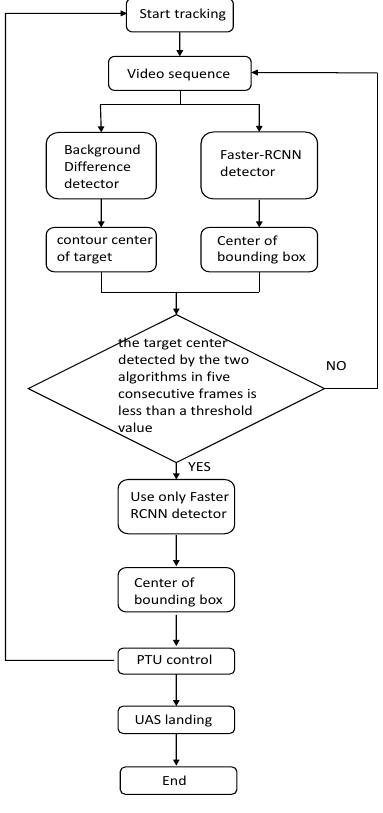
Figure 9. Combination